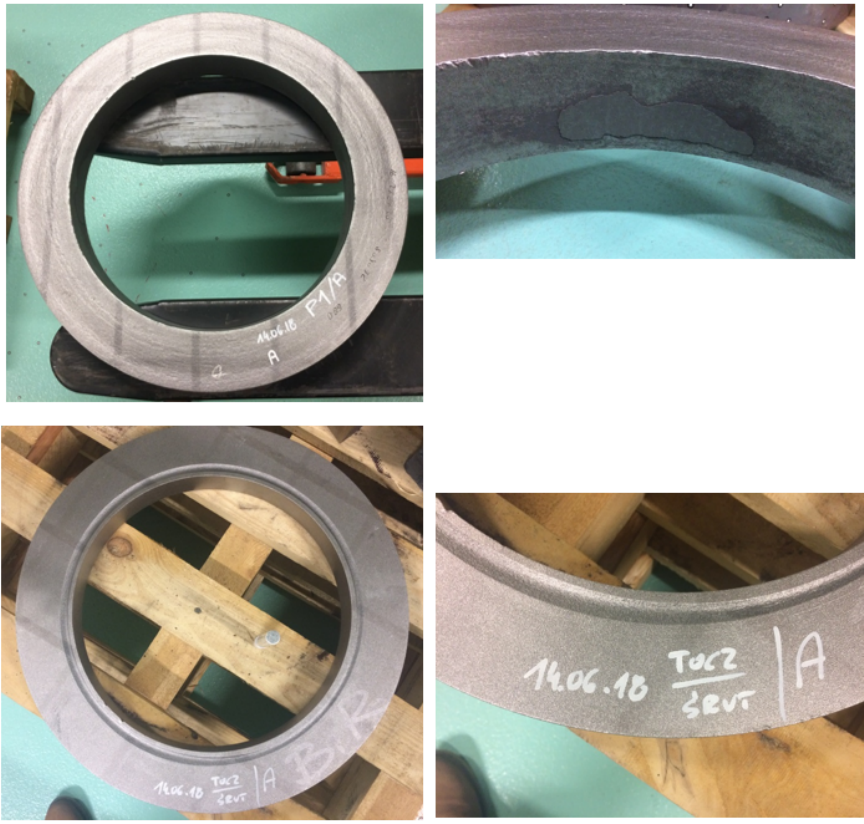
Figure 3. Ring R1 ( top row ) and R2 ( bottom row ); images in right column represent the magnified views of the corresponding rings.